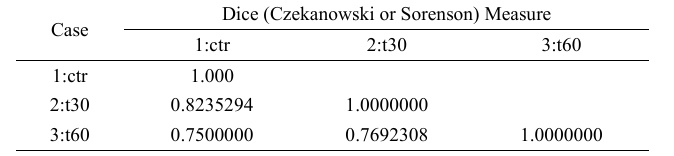
Fig. 5: Dendrogram obtained from analysis based on a rapid test using the UPGEMA method by NTSYS-PC Table 9: Similarity matrix for the control samples and samples treated with Nisin